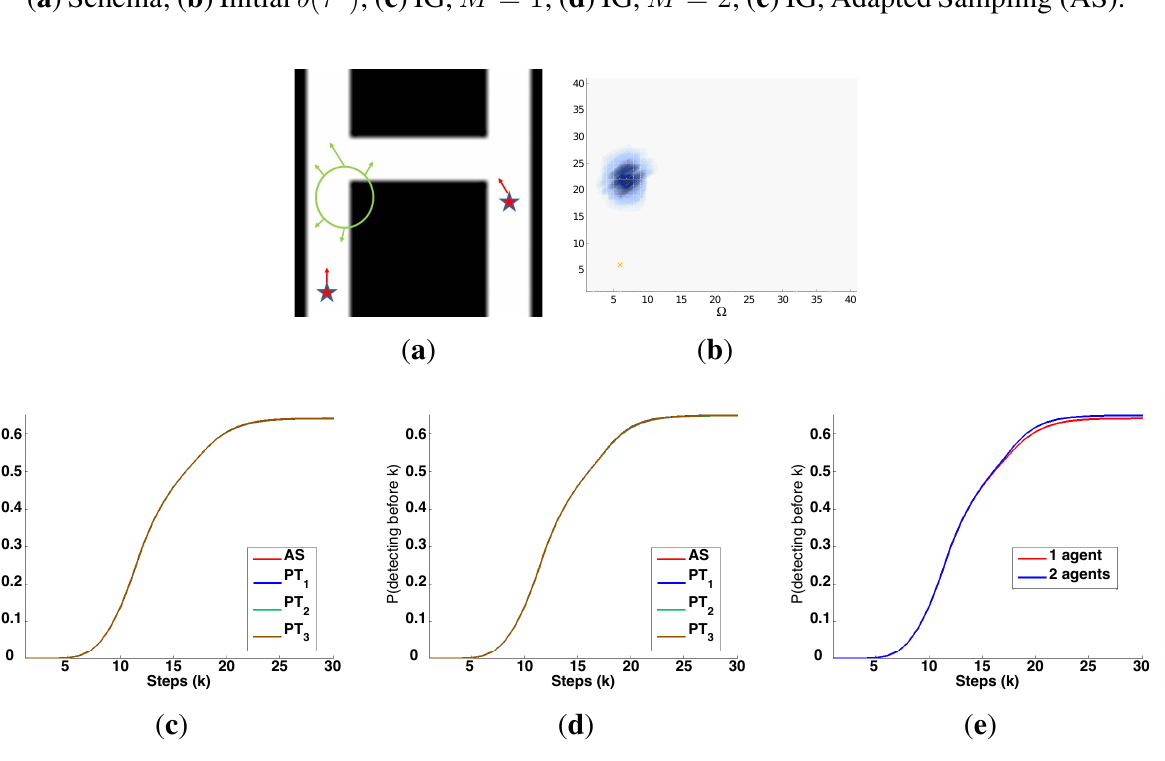
Figure 12. Properties and IG curves of the dynamic ultrasonic scanner experimental